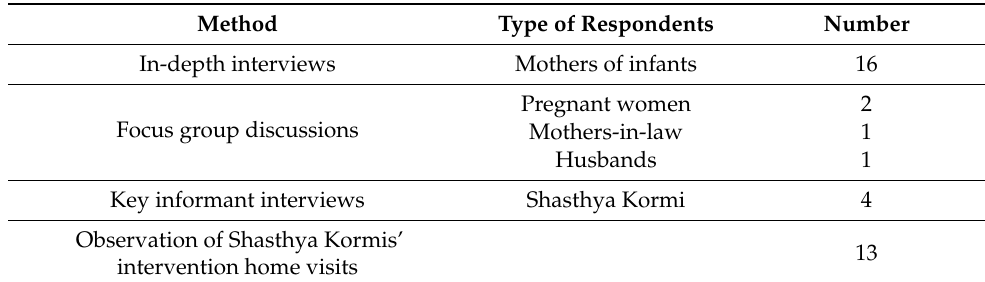
Table 2. Methods and sample